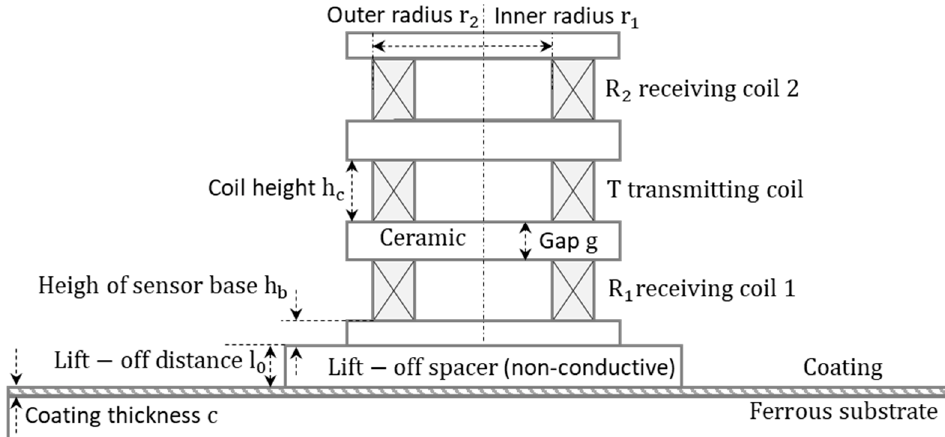
Figure 1. Circular coils above a dual ‐ layer structure.